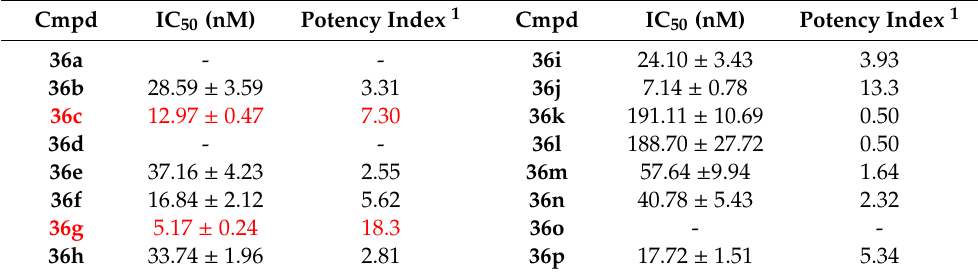
Table 4. Inhibition of Ee AChE by amidotacrines 36a – p (data from [94]).